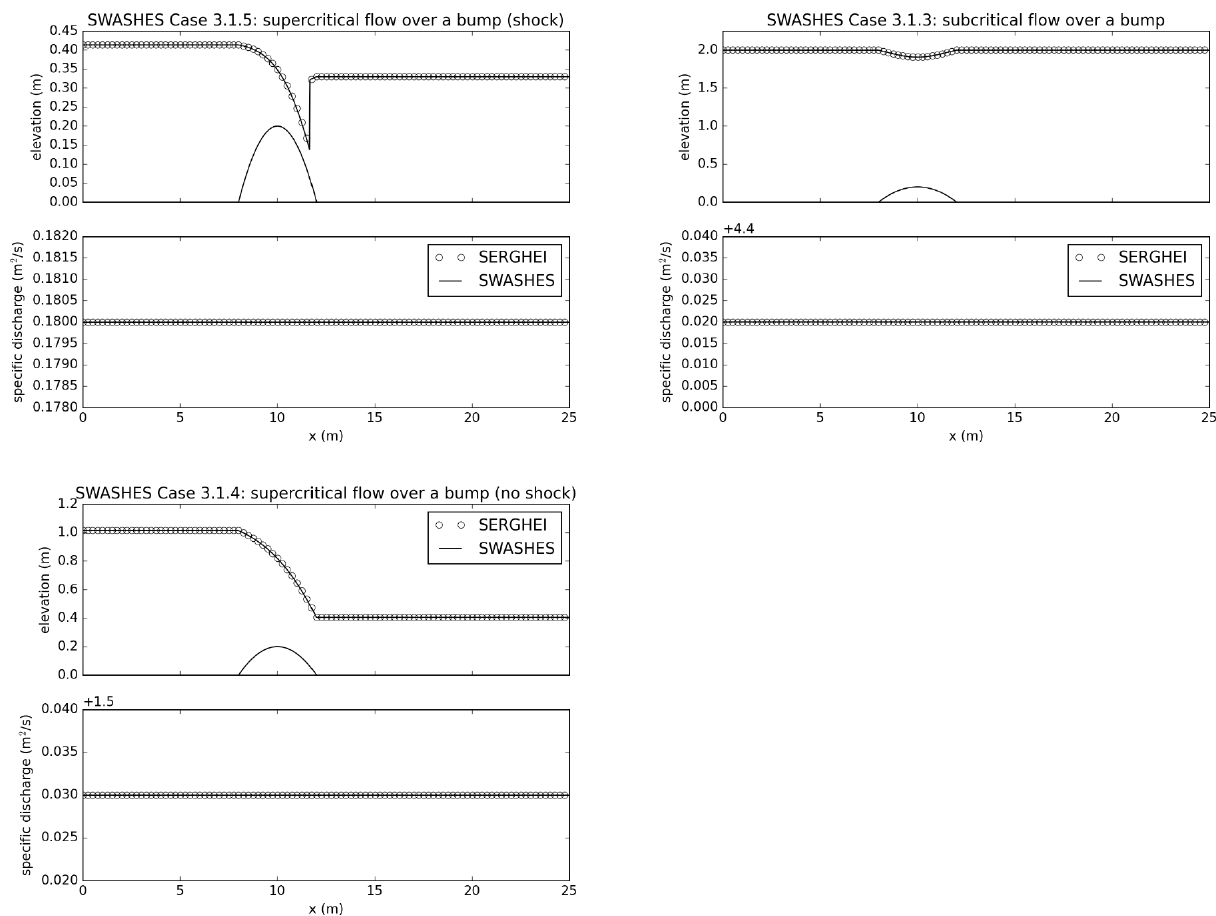
Figure A2. Analytical steady flows over a bump. SERGHEI-SWE captures moving equilibria solutions for transcritical flow with a shock (top left), fully subcritical flow (top right), and transcritical flow without a shock (bottom)